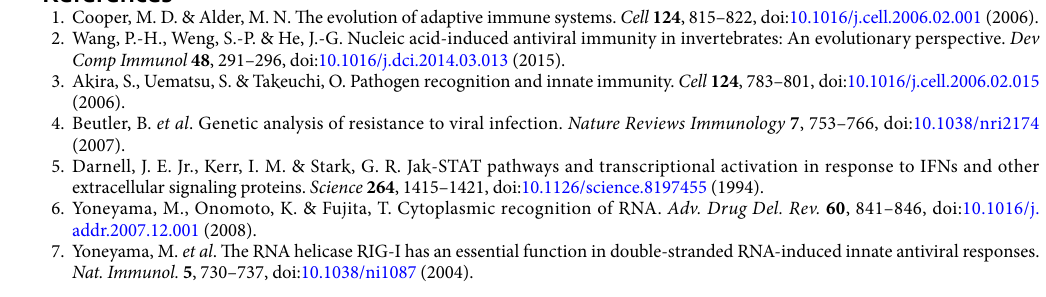
Yeast two-hybrid